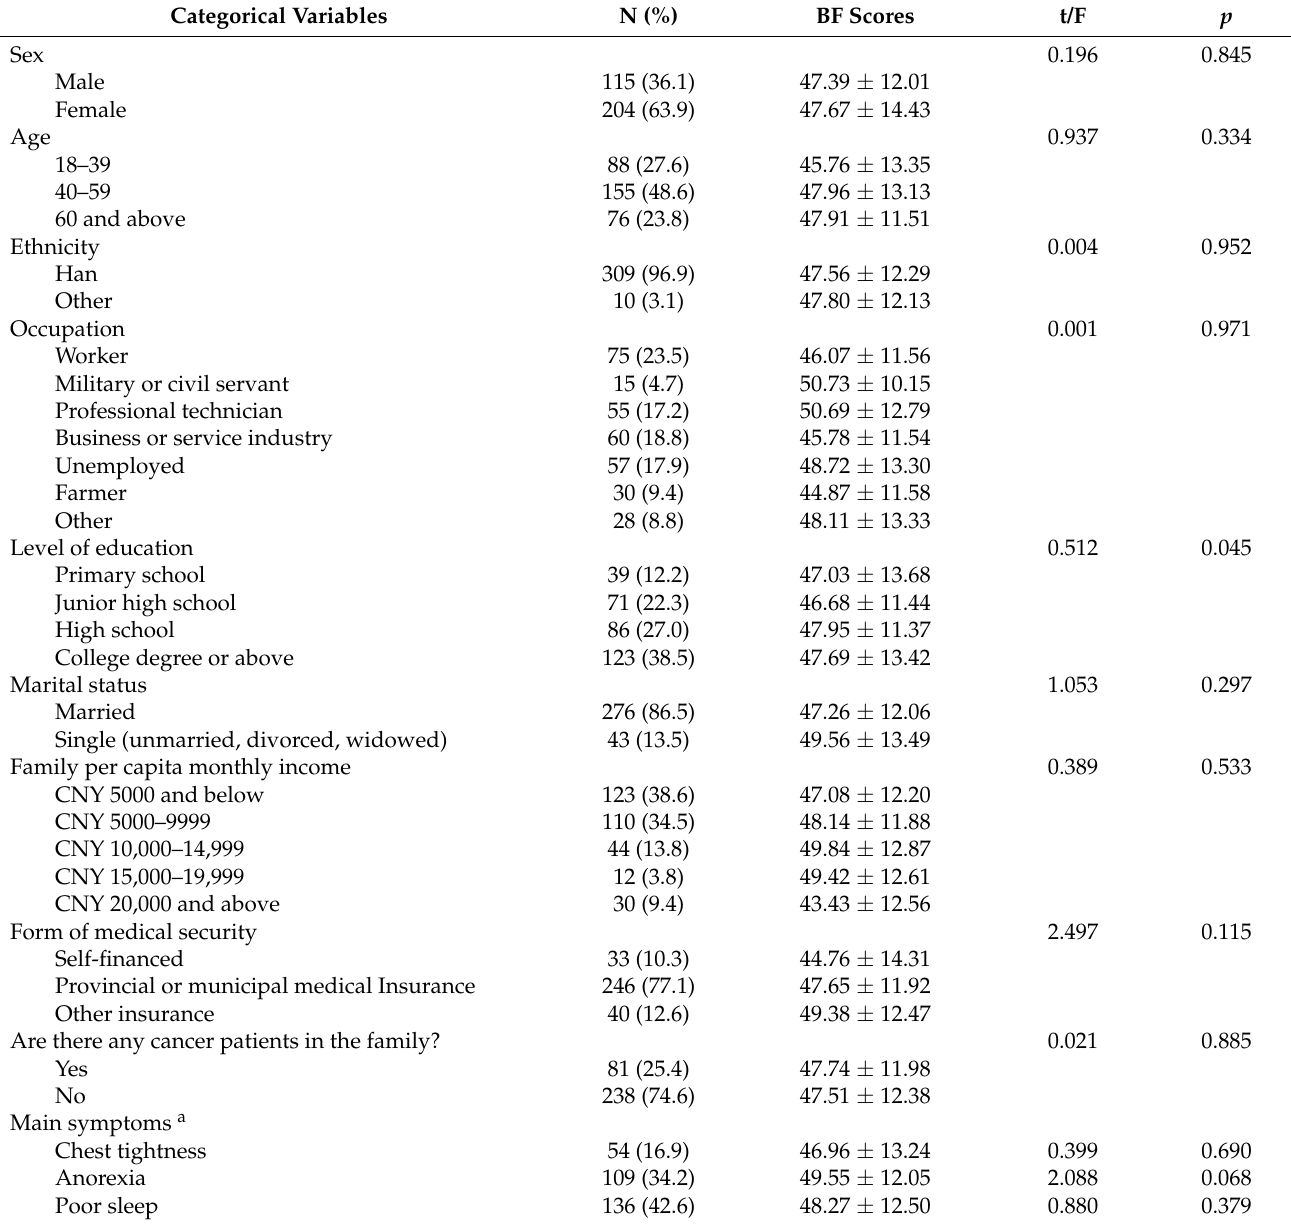
Table 2. Demographic characteristics of the study sample (N =